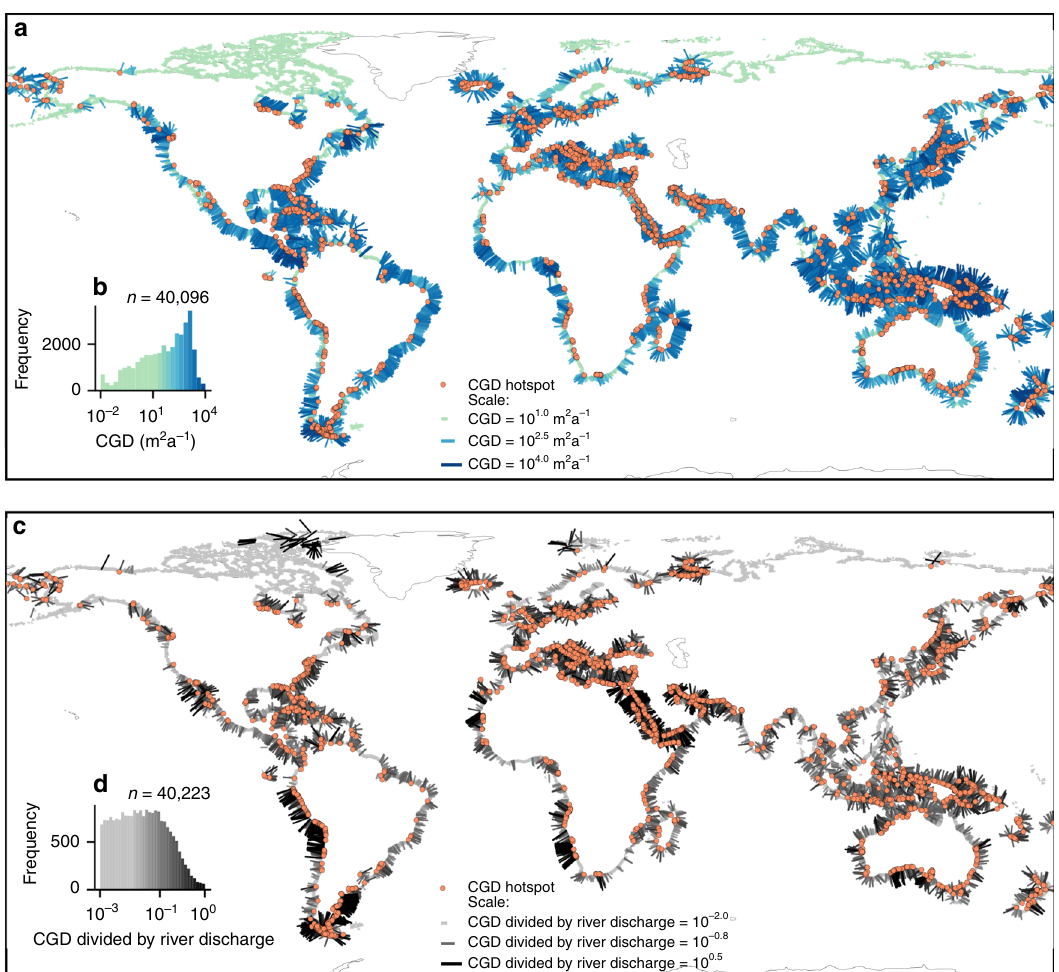
Fig. 3 Global maps of coastal groundwater discharge and comparison with surface water discharge. The maps show that the fl ow of groundwater to the oceans is highly variable, dominated by localized hotspots, and can locally be a source of water that rivals surface water discharge. a Coastal groundwater discharge (CGD), and b CGD divided by the surface water fl ux to the oceans. The coastal groundwater discharge and surface water discharge data that are shown here are available in Supplementary Data